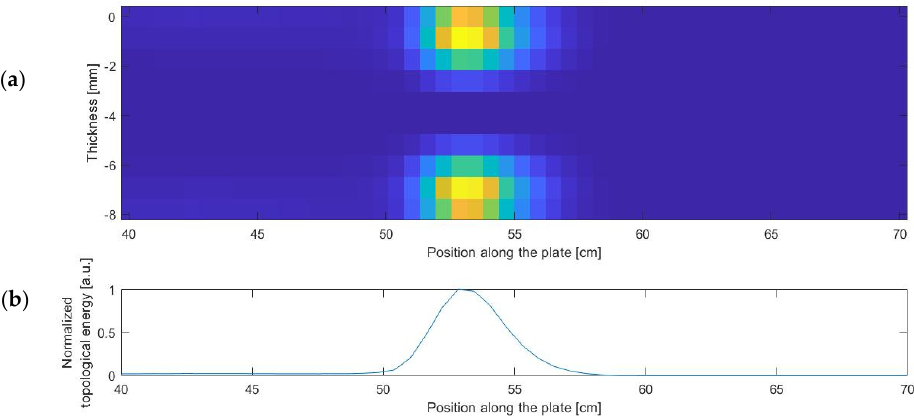
Figure 12. ( a ) Topological image in the region of interest of the simulated plate. ( b ) Normalized sum of the topological energy at each position along the plate.